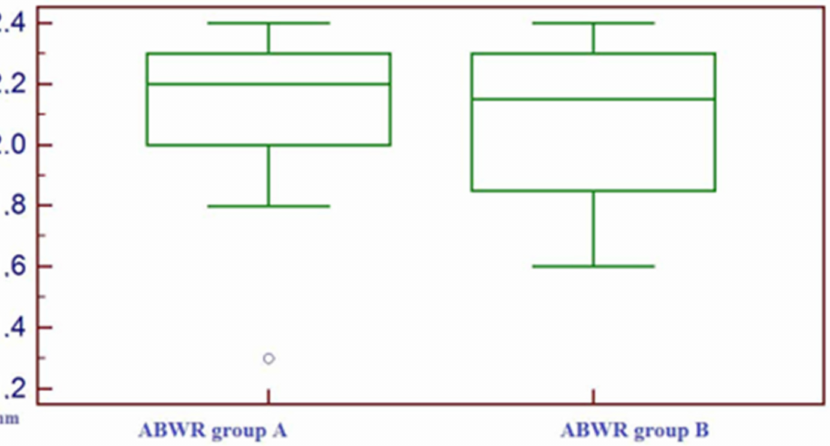
Figure 5. Box–whisker plot representing the distribution of alveolar bone width reduction (ABWR) on group A and on group B.